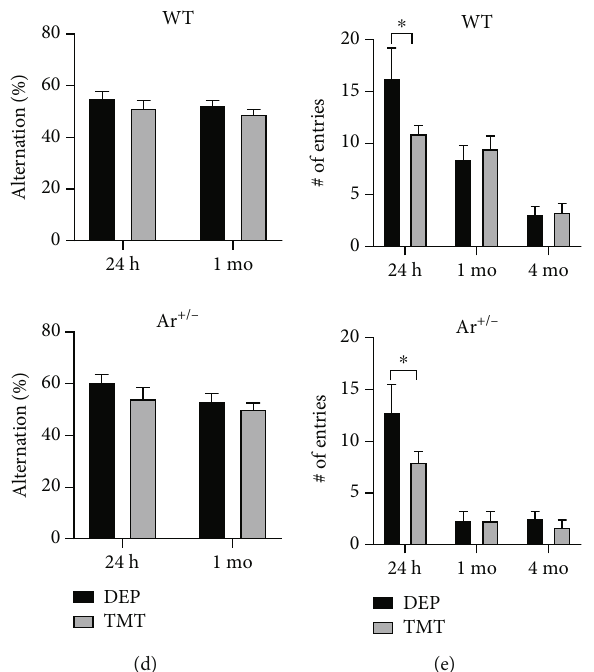
Figure 1: Procedures of experiments and behavioral changes after TMT exposure. (a) Procedures of experiments. (b) Freezing time increased signi fi cantly after TMT exposure in two genotypes in both sexes. (c) Open fi eld test and (d) Y-maze test at baseline, 24h, 1 month, and 4 months after TMT exposure in the WT mice and Ar+/- mice. (e) Results of plus maze test at 24 h, 1 month, and 4 months after TMT exposure in both WT mice and Ar+/- mice. Data are shown as mean ± SEM ; #### P < 0 : 0001 , ### P = 0 : 0008 vs. TMT-treated mice. ∗ P < 0 : 05 between groups as